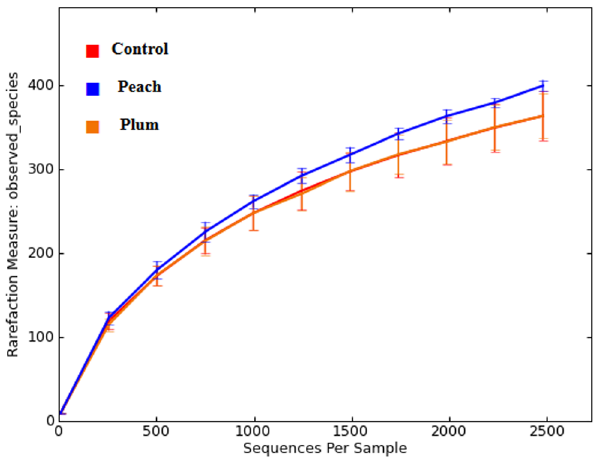
Figure 4. Rarefaction plots of 16S rRNA gene sequences obtained from fecal samples. Lines denote the average of each group; error bars represent the standard deviation. This analysis was carried out using a randomly selected 2489 sequences per sample.